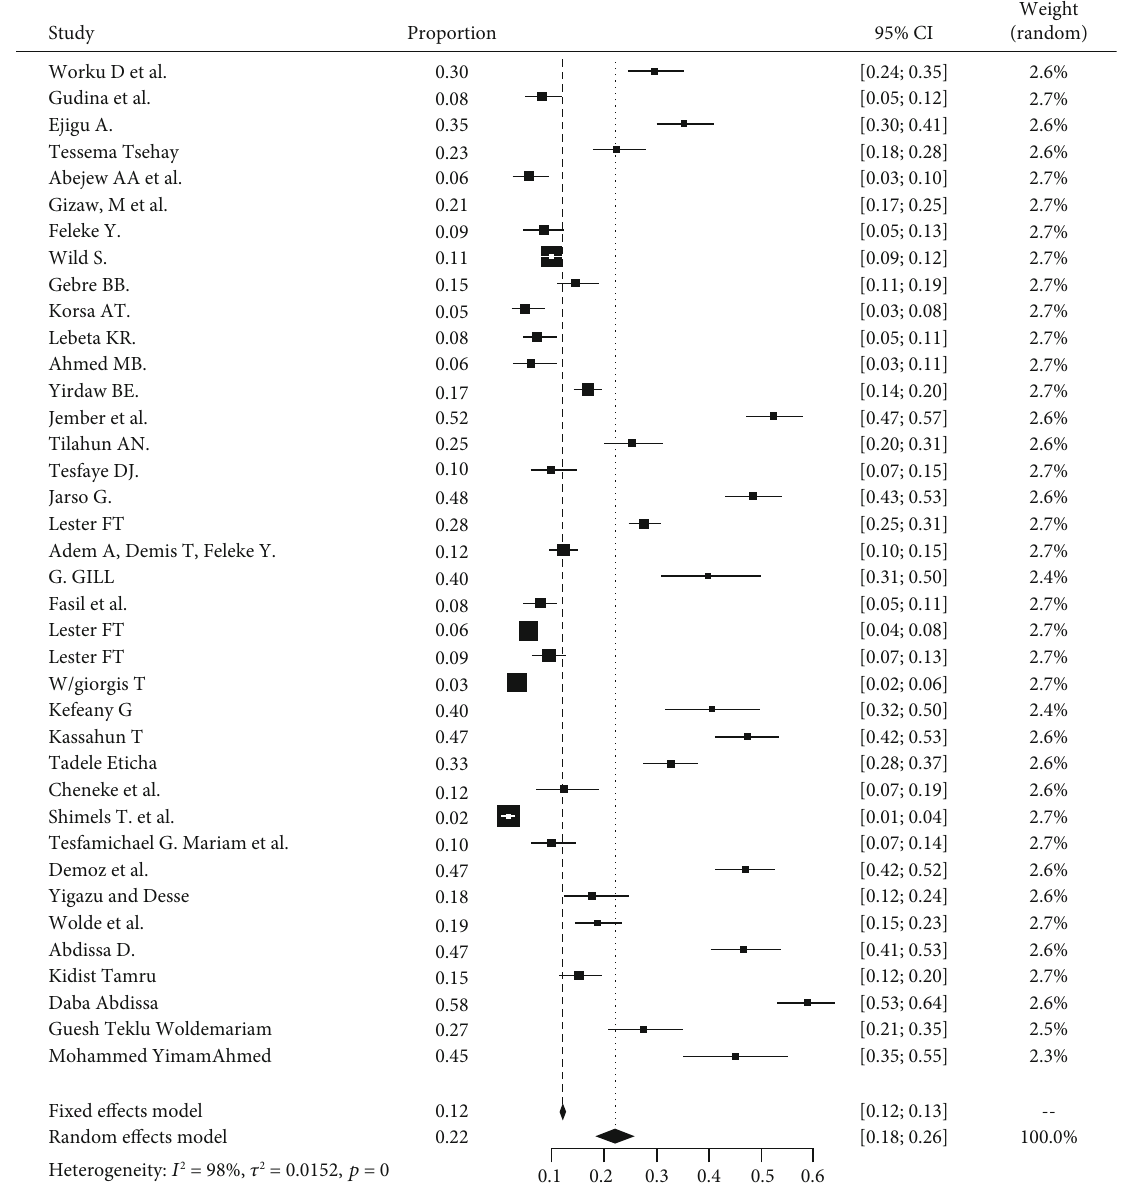
Figure 2: Forest plot for the pooled prevalence of DPN from 38 observational